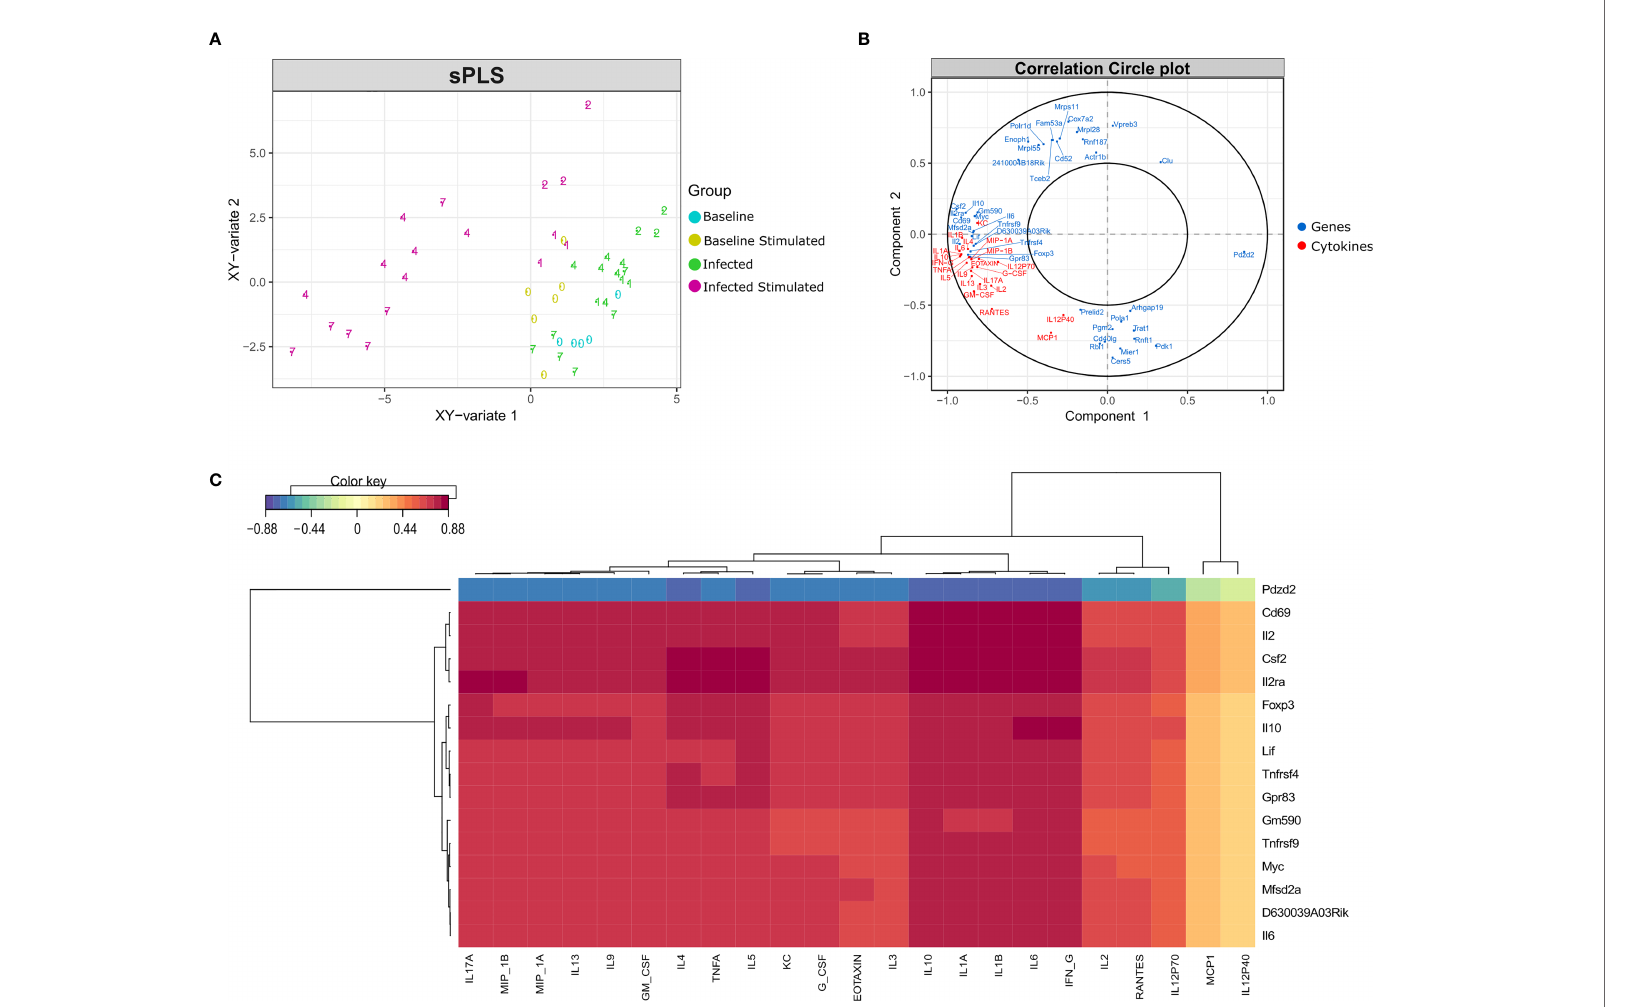
FIGURE 7 | Data integration using sPLS (Sparse Partial Least Squares). Data integration suggests a different pattern in stimulated samples from days 4 and 7 after infection, driven by the expression of a few genes and the concentration of most cytokines. (A) sPLS: Partial Least Squares regression applying the tune.spls function (MixOmics), 16 genes were selected for component 1 and 25 genes for component 2. Colors represent samples from different groups: infected or non-infected and with or without in vitro stimulation. Numbers indicate the study days. (B) Correlation Circle Plot: the selected genes (blue) and cytokines (red) are represented in a correlation circle plot. Variables positively associated are projected in the same direction from the origin, variables negatively correlated are projected in opposite directions. Variables displayed in a perpendicular angle are not correlated and the greater the distance from the origin the stronger the association. For example, the cytokine IL1B is positively correlated with the IL2 gene, but is negatively correlated with the gene Pdzd2. In general, cytokines and several genes related to cytokines are accumulated on the left side of the graph, indicating a high correlation among them. (C) Clustered Image Map (CIM): correlation between genes (mRNA), reported in vertical, and Cytokine production, in horizontal. The map highlights the correlation values for these variables for the genes selected on the fi rst component of the sPLS. High positive correlations are represented by dark red, while high negative correlations by dark blue. Genes related to cytokines such as Il2ra, Csf2, Il10, Il6 and Il2 are positively correlated with most cytokines concentration. The select genes are strongly correlated with almost all cytokines, with exception of MCP1 and